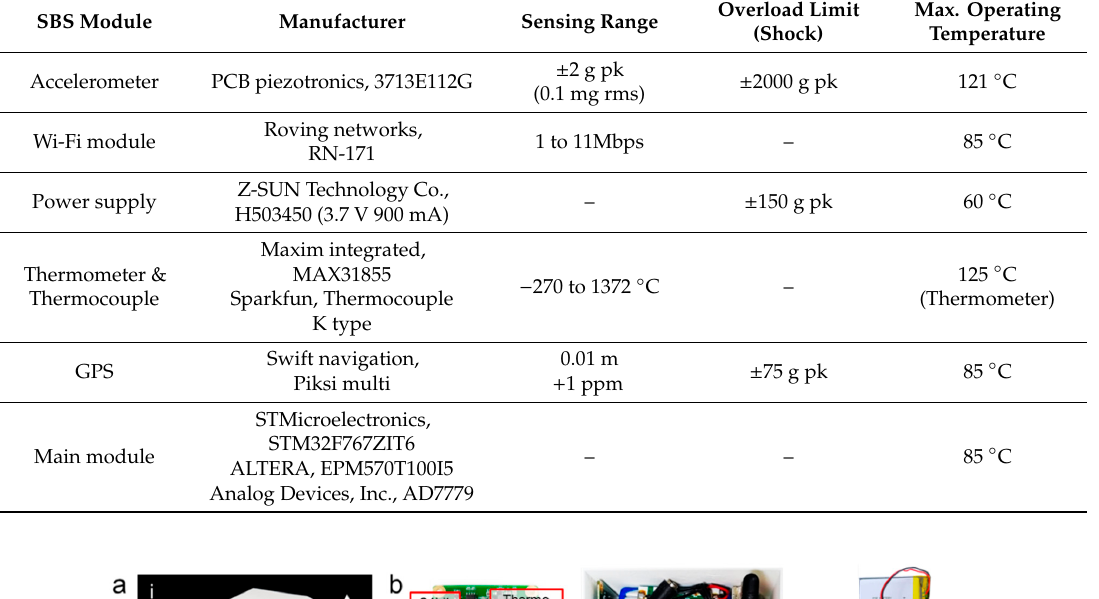
Table 1. Summary of manufacturer, sensing range and limit conditions for each sensor module.